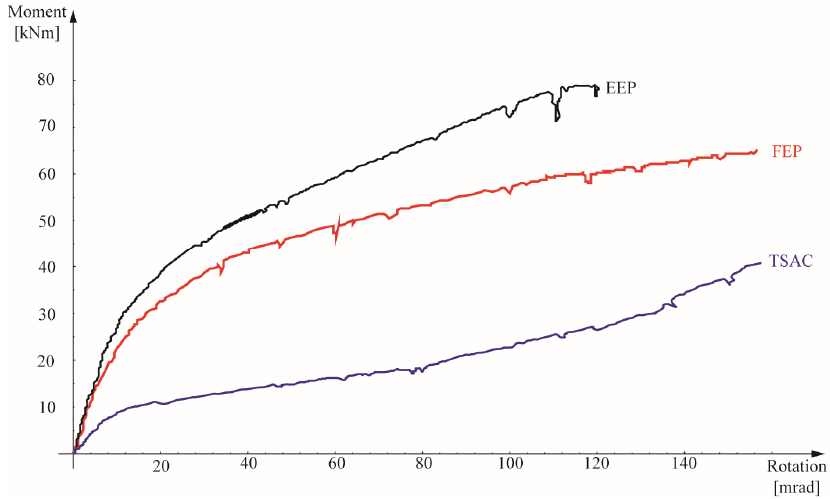
Figure 7. Comparison of experimental moment–rotation relationships for EN 1.4301 stainless-steel.